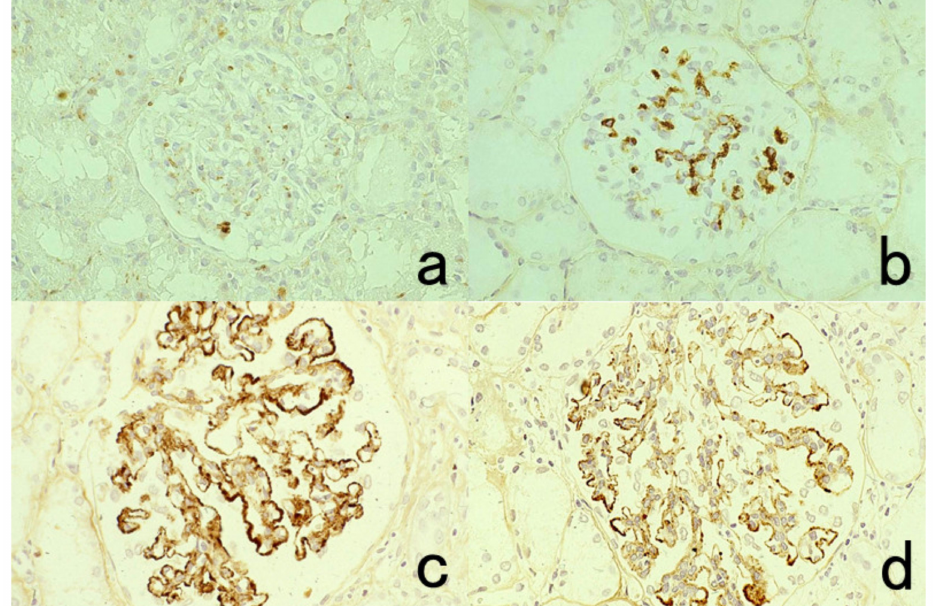
Figure 31. Detection of glomerular deposits of immunoglobulins and complement in FFPE renal biopsy sections with the aid of prolonged 0.1% trypsin digestion for 120 min. ( a , b ): IgA nephropathy (IgA staining, ( a ): without digestion, ( b ): after digestion). Mesangial deposition of IgA is evident in ( b ). ( c , d ): Membranous nephropathy after 0.1% trypsin digestion for 120 min (( c ): IgG, ( d ): C3). Granular deposition of IgG and C3 is observed along the capillary loop, a diagnostic feature of membranous nephropathy.